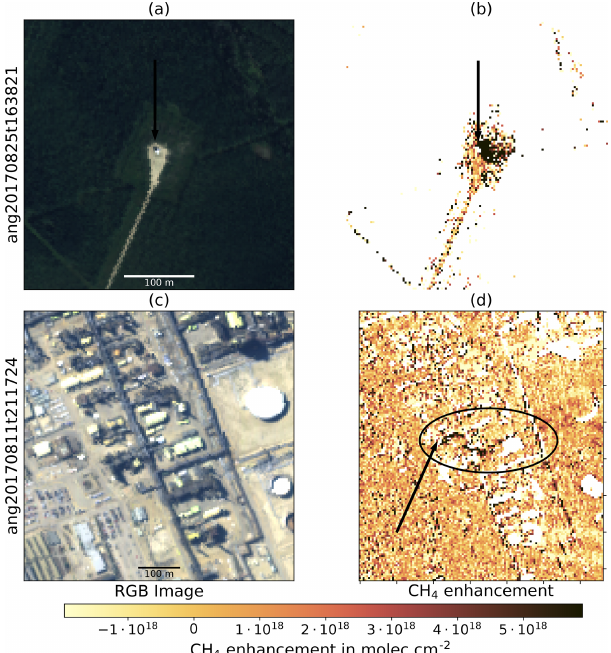
Figure C2. Similar to Fig. C1 but for methane enhancements from oil/gas infrastructure. In panels (a) and (b) , the emissions originate from a well pad in a forest. Due to the low radiance over the trees, only the well pad itself passes the quality filters. The enhancements seem accumulated, and no clear wind direction is visible. In panels (c) and (d) , a facility located at a bitumen extraction site is shown, and the methane plume meanders around the facility.